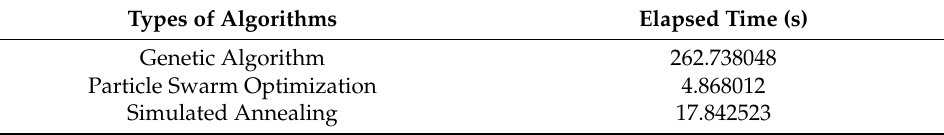
Table 1. The elapsed time of three algorithms to complete the optimal